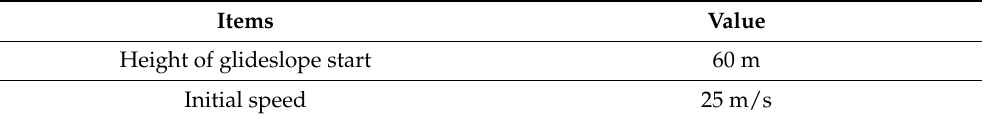
Table 7. Conditions of simulation for cases 1 and 2.